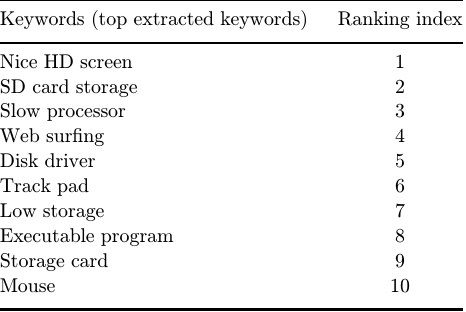
Table 8. Extracted keywords from the top critical reviews for laptops. Keywords (top extracted keywords)